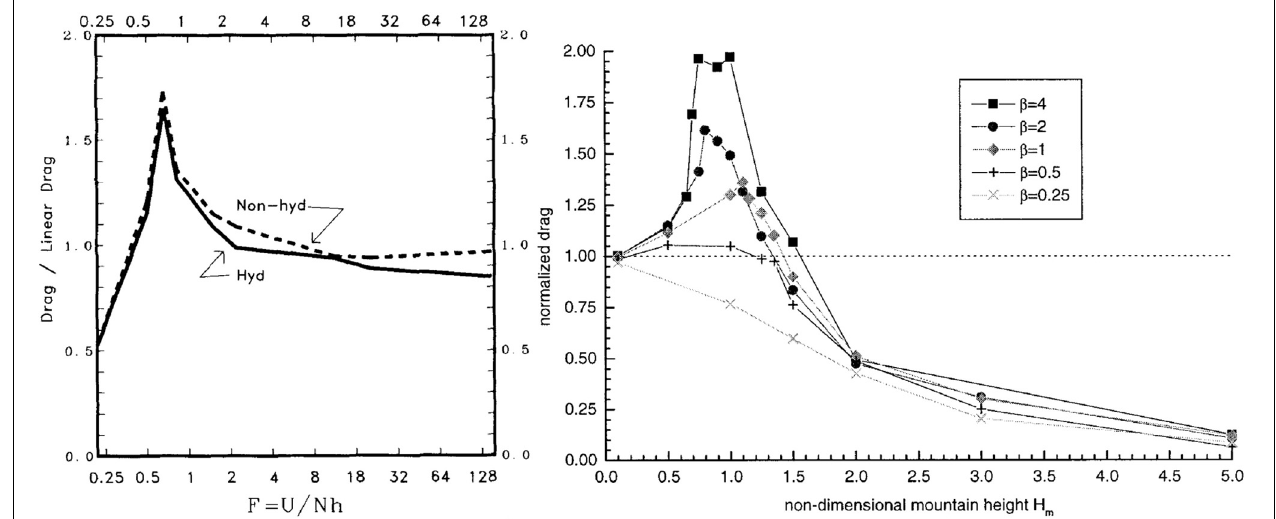
FIGURE 14 | Left: drag in flow over an axisymmetric bell-shaped mountain normalized by its linear hydrostatic value (solid line) and by its linear non-hydrostatic value (dashed line) as a function of ˜ h − 1 . Reproduced from Figure 1 of Miranda and James [126]. Copyright © 1992 Royal Meteorological